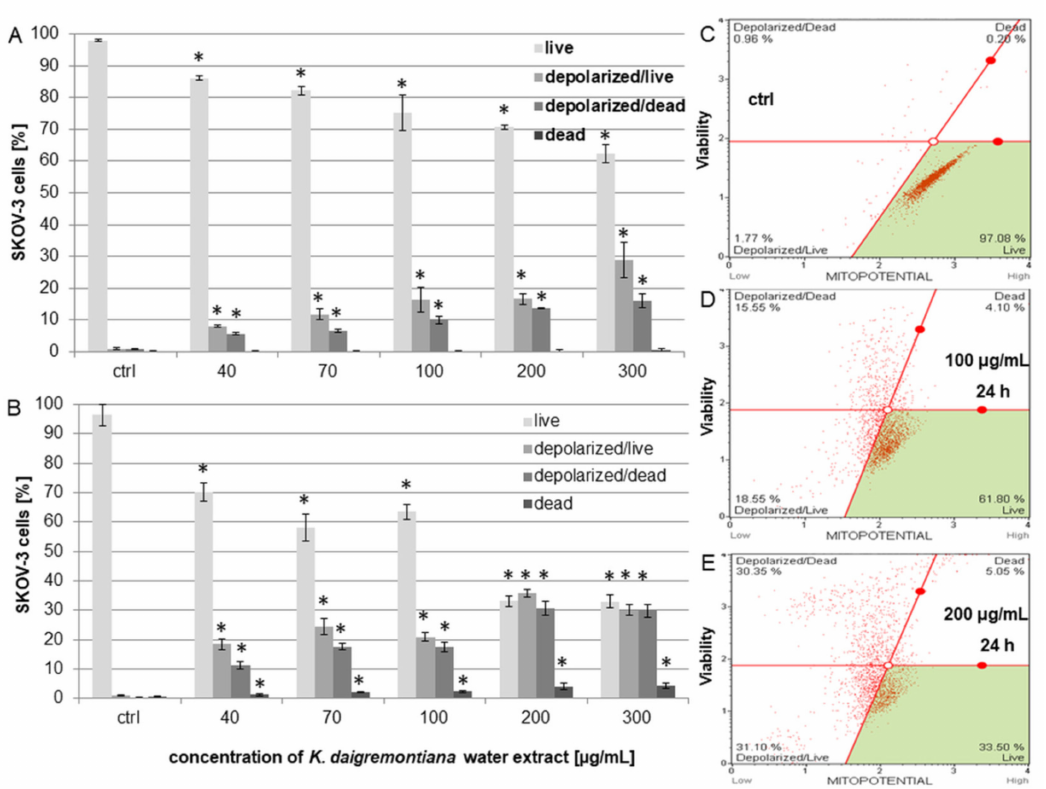
Figure 6. Kalanchoe daigremontiana water extract induced decreases in MMP of SKOV-3 cells. The cells were incubated with the extract at concentrations of 40–300 µ g/mL for 6 ( A ) and 24 h ( B ) and analyzed via flow cytometry. The values represent the means ± SD of three independent experiments. Error bars represent standard deviations. Significant differences relative to the control are marked with an asterisk “*” (Student’s t -test, p < 0.05). The plots show the results after 24 h of treating